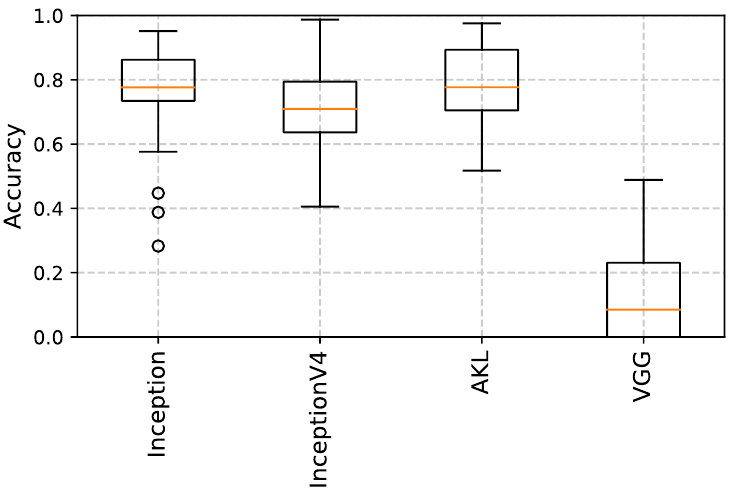
Figure 14. IoU of object localization of different CNN architectures for images of size 256